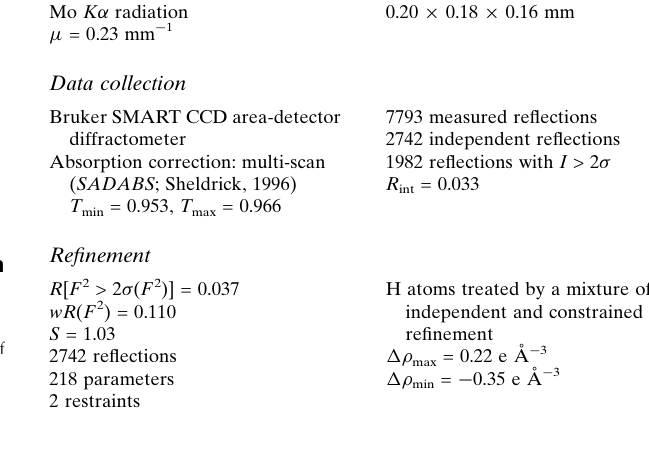
Hydrogen-bond geometry (A˚ , (cid:1)